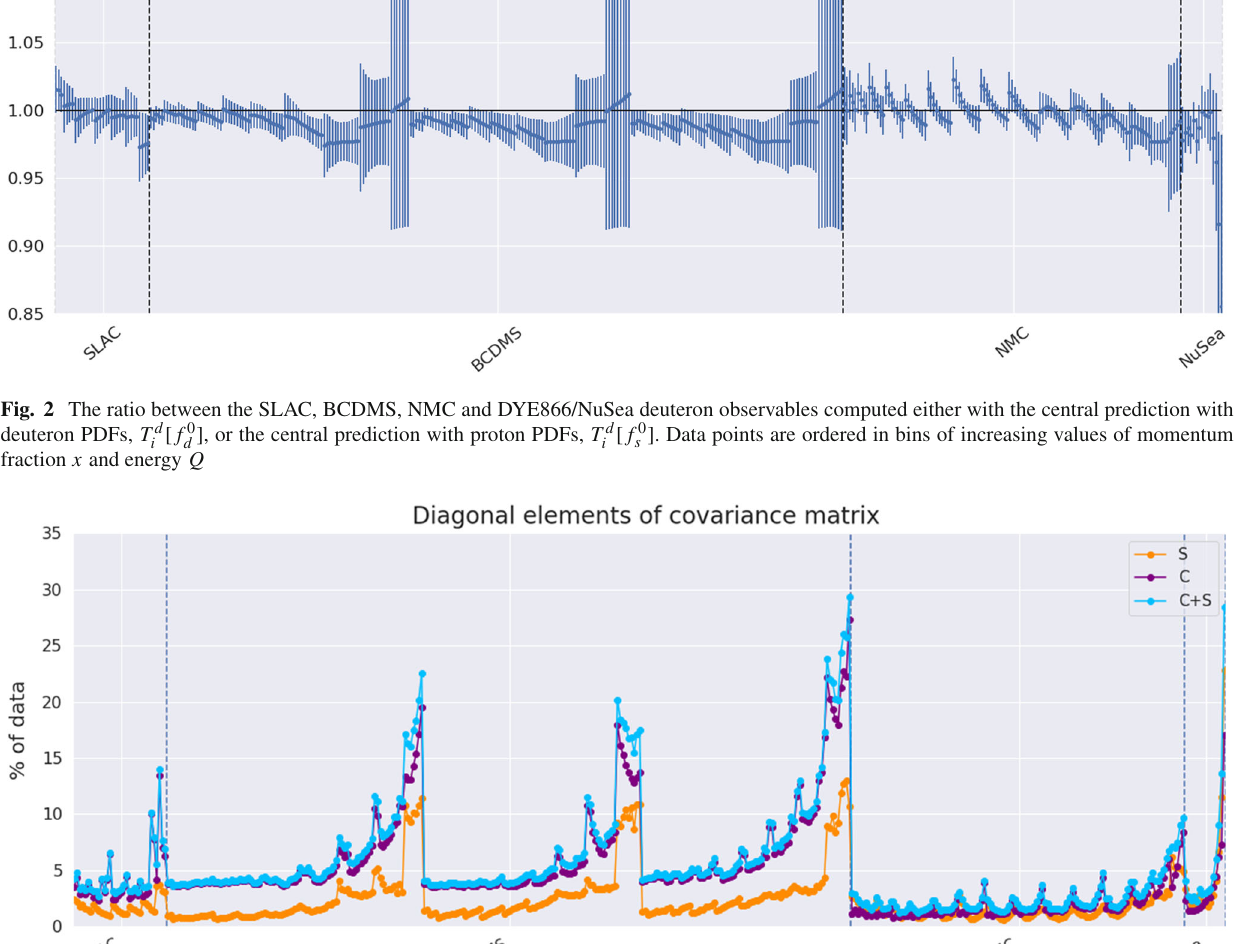
DYE866/NuSea. We show results for the experimental covariance √ cov ii / D i , matrix ( C ) , for the deuteron covariance matrix ( S ) , computed from Eq. (3), and for their sum ( C + S